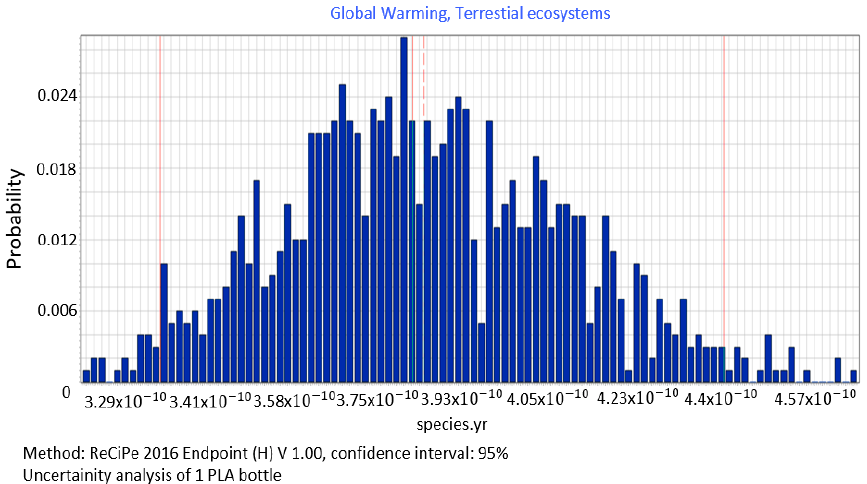
Figure 11. Results of the uncertainty analysis for the category of global warming and its influence on the ecosystem quality.